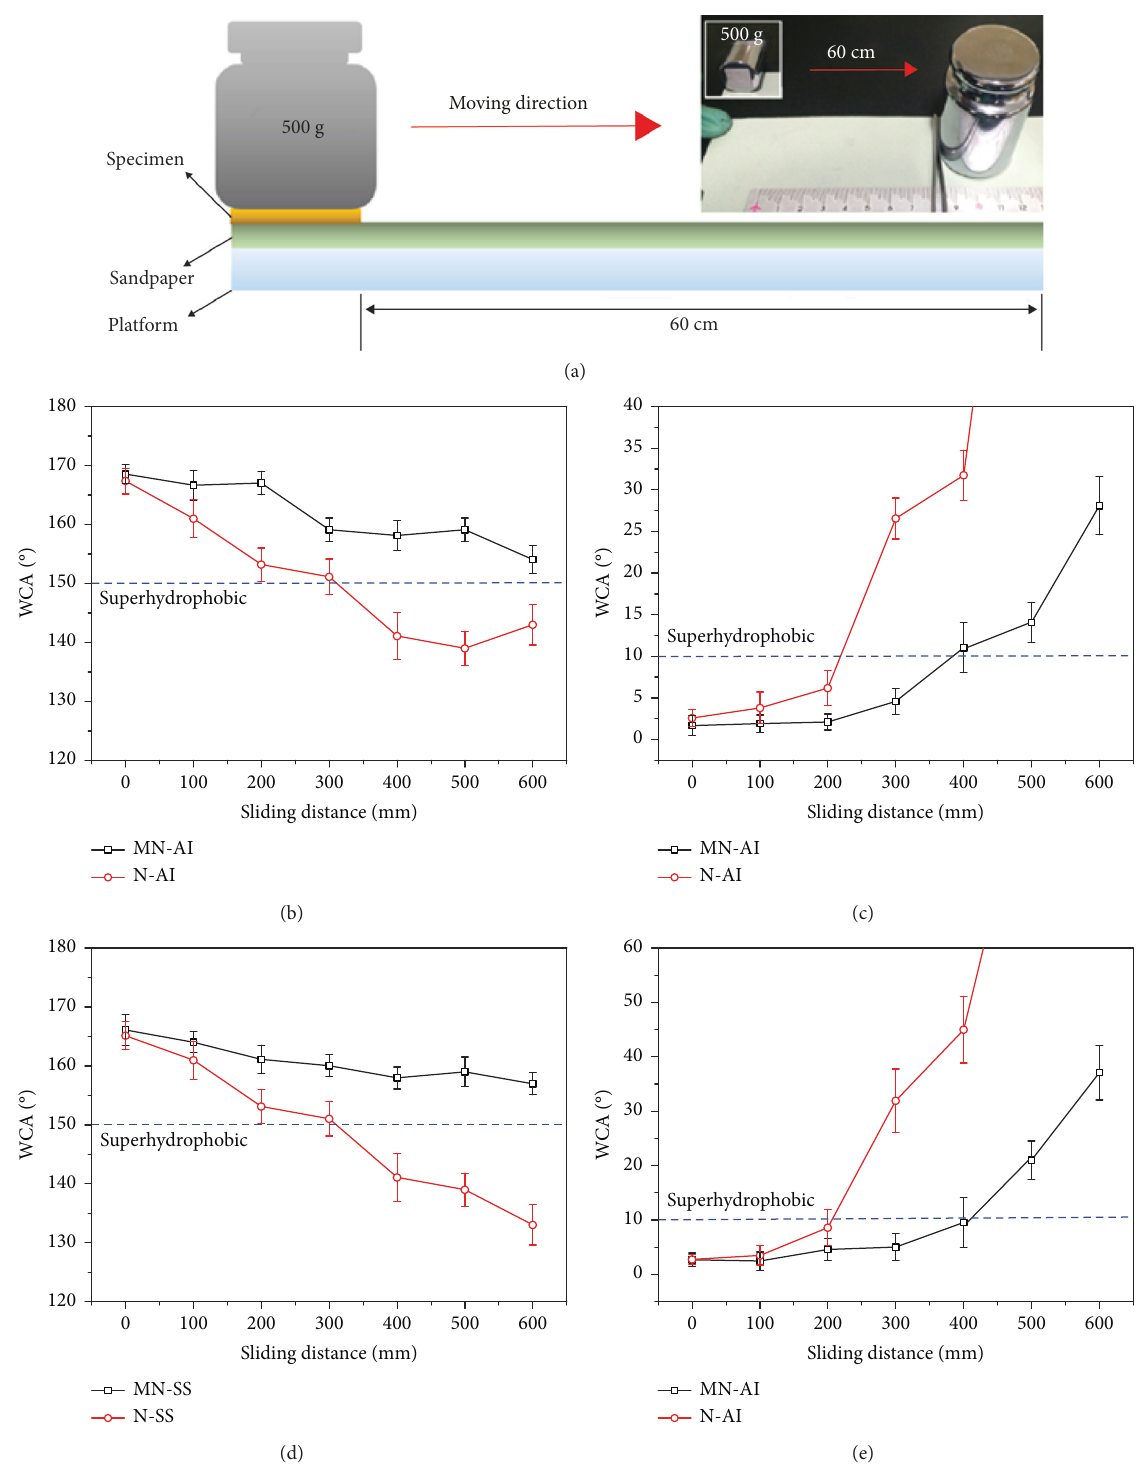
Figure 10: (a) Sandpaper abrasion test. (b–e) The contact angle and sliding angle of brine with respect to abrasion length on the MN-Al, N- Al, MN-SS, and N-SS